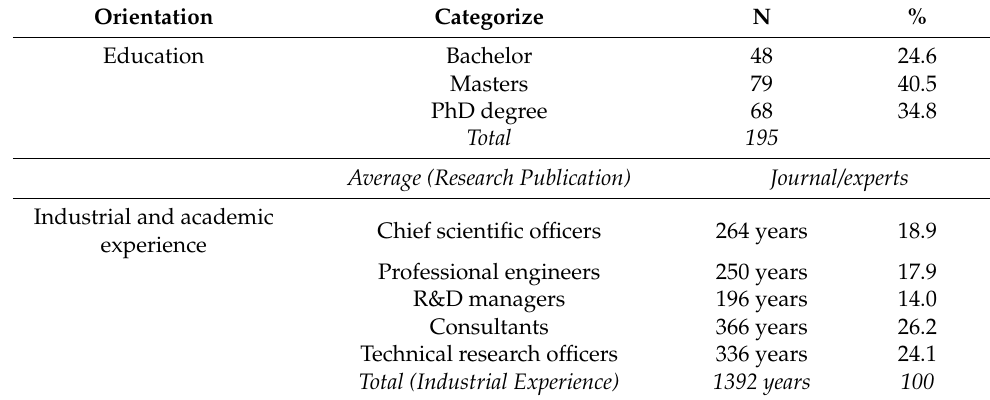
Figure 8. The IRM for the IM process capability (T Criteria ).